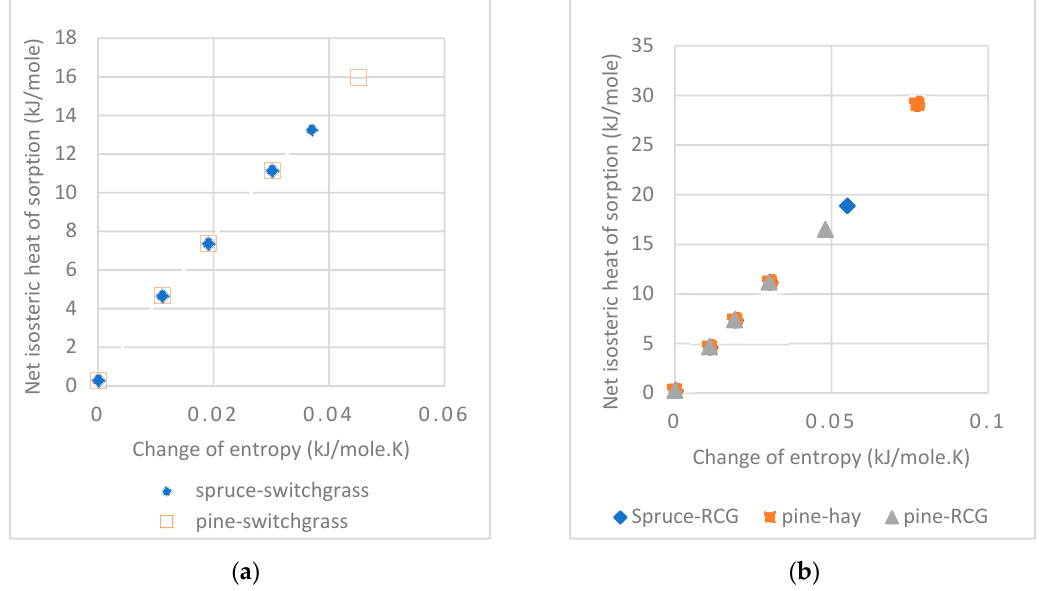
Figure 5. Representation of the net isosteric heat of sorption versus the change of entropy ( a ) pellets of this study and ( b ) pellets studied by Bennamoun et al. [30].